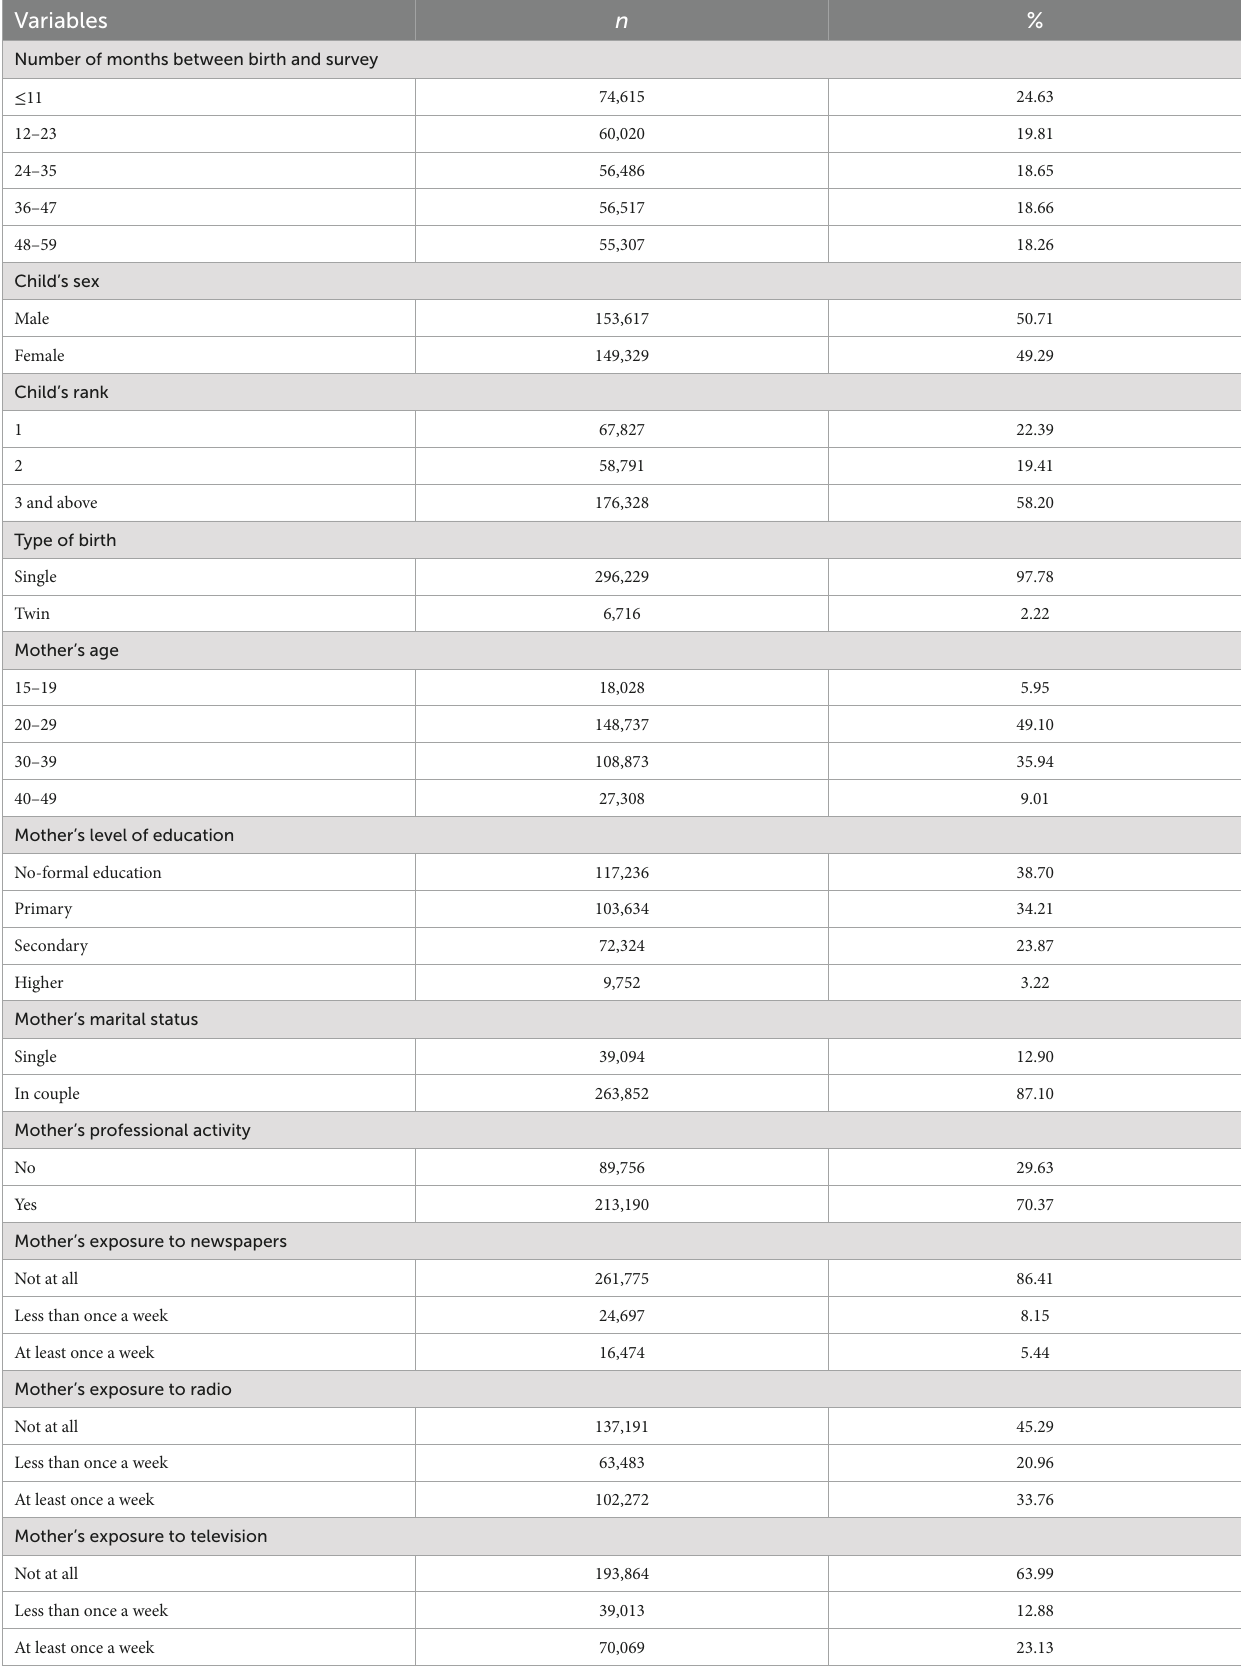
TABLE 3 Basic characteristics of surveyed children in SSA,